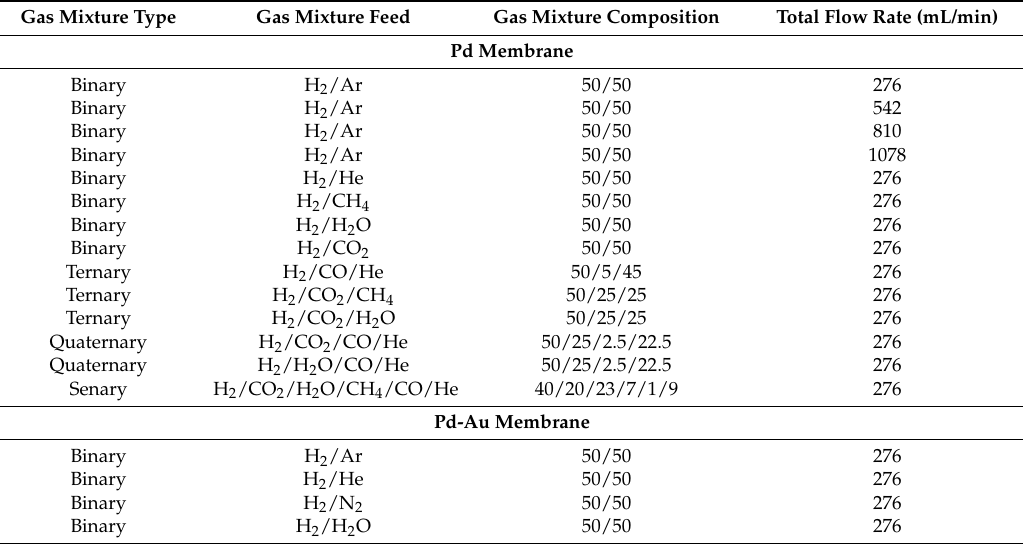
Table 1. Gas mixtures fed into the Pd and Pd-Au MRs at 400 ◦ C for permeation